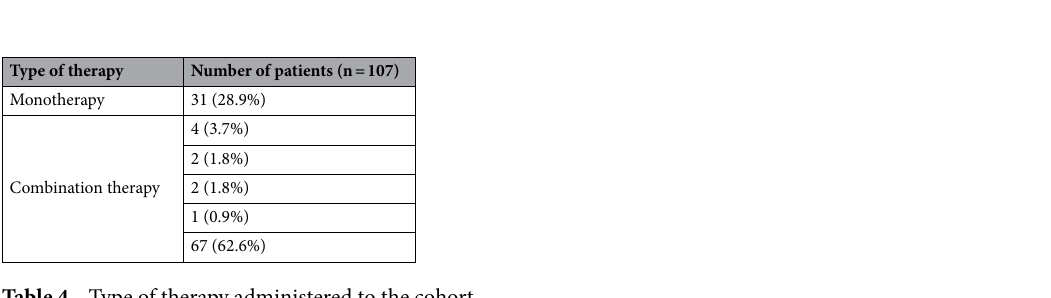
Table 4. Type of therapy administered to the